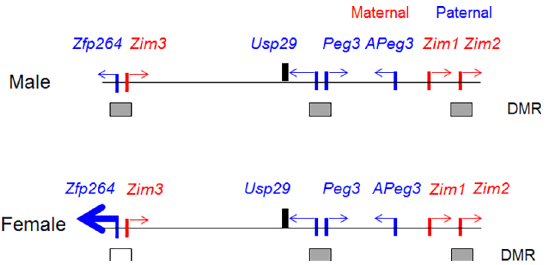
Fig 8. Summary of the mutational effects by the knockin allele. The mutational effects by the knockin allele are summarized in a schematic representation. The knockin allele truncates the transcription of Usp29 in both male and female heterozygotes carrying the knockin allele paternally, indicated by the thick vertical lines. In the female heterozygotes, this transcriptional truncation of Usp29 also results in the dramatic up- regulation of Zfp264 in brain, indicated by a much thicker arrow compared to that in the male heterozygote. This up-regulation of Zfp264 in the female heterozygotes coincides with the DNA hypomethylation on the promoter of Zfp264 , indicated by the white box instead the grey